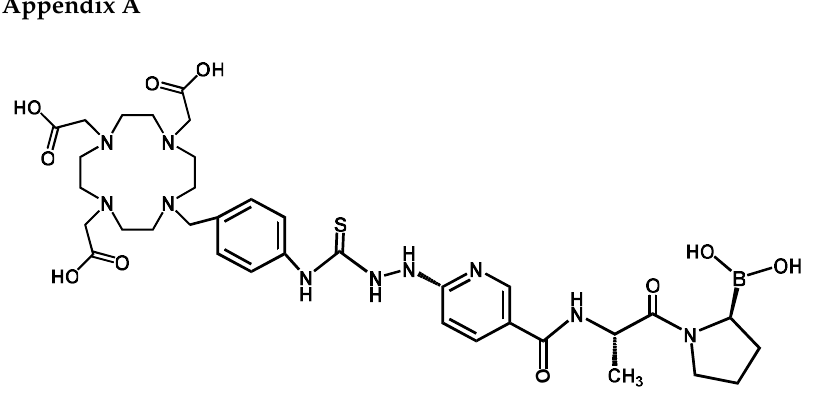
Figure A1. Chemical structure of 2,2′,2″,2′″-(2-(4-(2-(5-(((S)-1-((S)-2-boronopyrrolidin-1-yl)-1-ox-